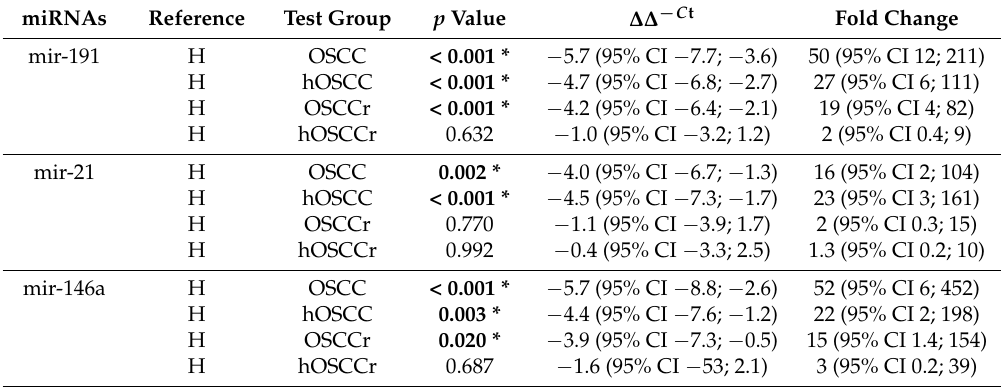
Table 2. Dunnet post hoc test for differently expressed miRNAs. Expression levels of miRNAs in each group of specimens were compared with healthy controls. Entries in boldface and with asterisk ( * ) indicate statistically significant p